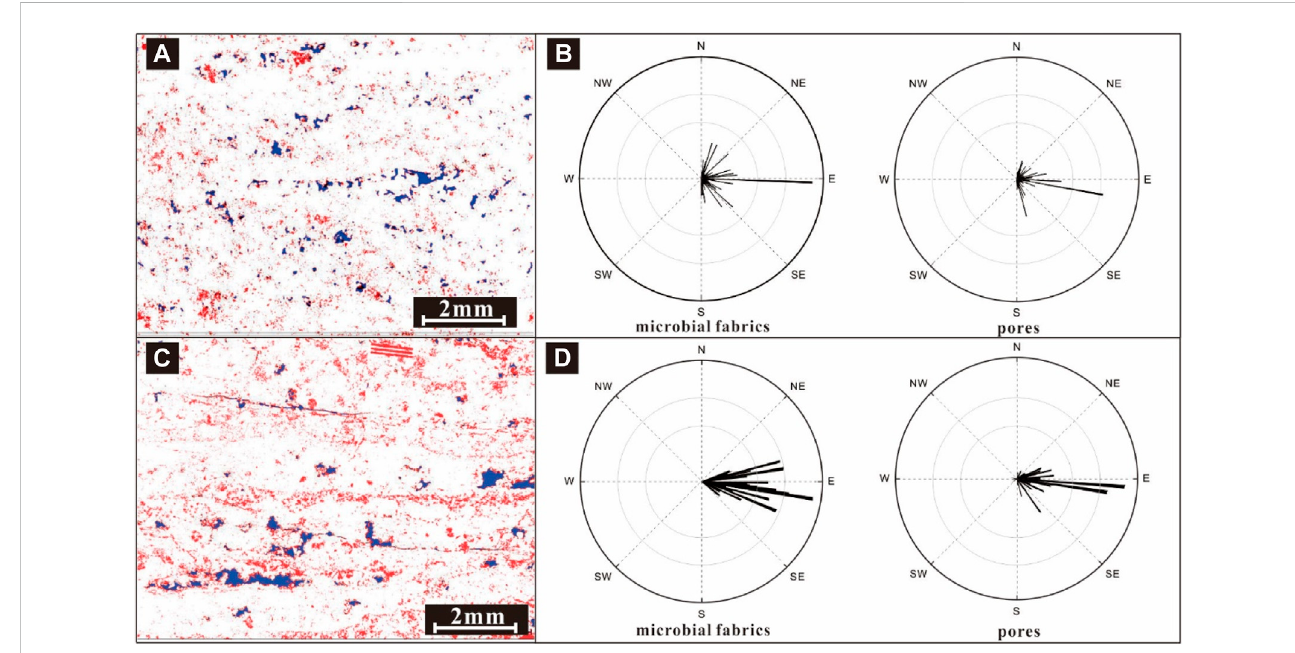
FIGURE 3 Quantitative statistics for occurrences (size and orientation) of pores and microbial fabrics in thrombolites and stromatolites showing close correlations betweentheporesandmicrobialfabrics. (A,C) Microphotosofthromboliteandstromatolite,respectively;theredarearepresentsthemicrobialfabricsandthe blue area represents the pores. (B) Rose diagram showing orientation and size of microbial fabrics and pores in thrombolites. (D) Rose diagram showing orientation and size of microbial fabrics and pores in